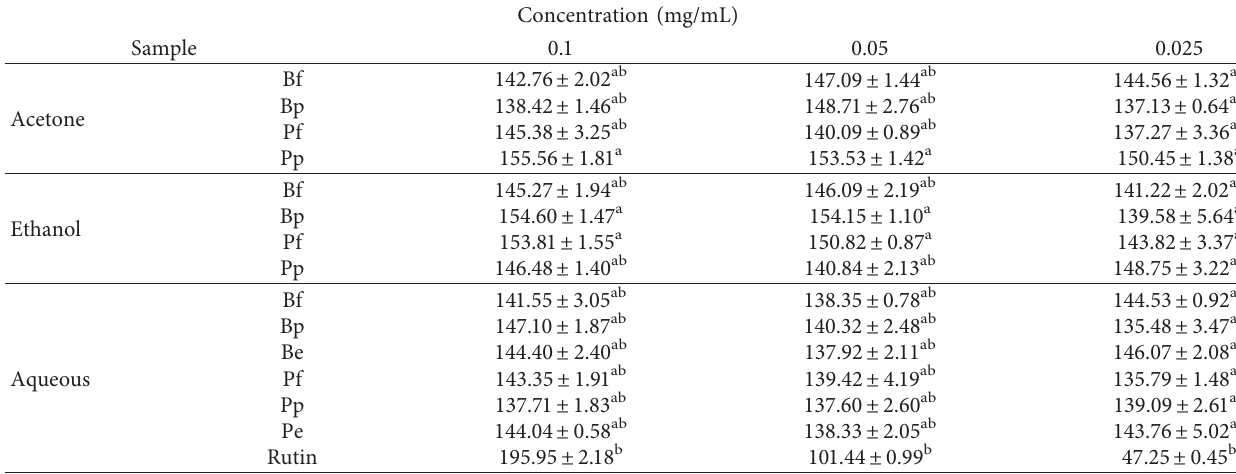
Table 4: Ferric reducing power (mg RE/g) of the extracts and